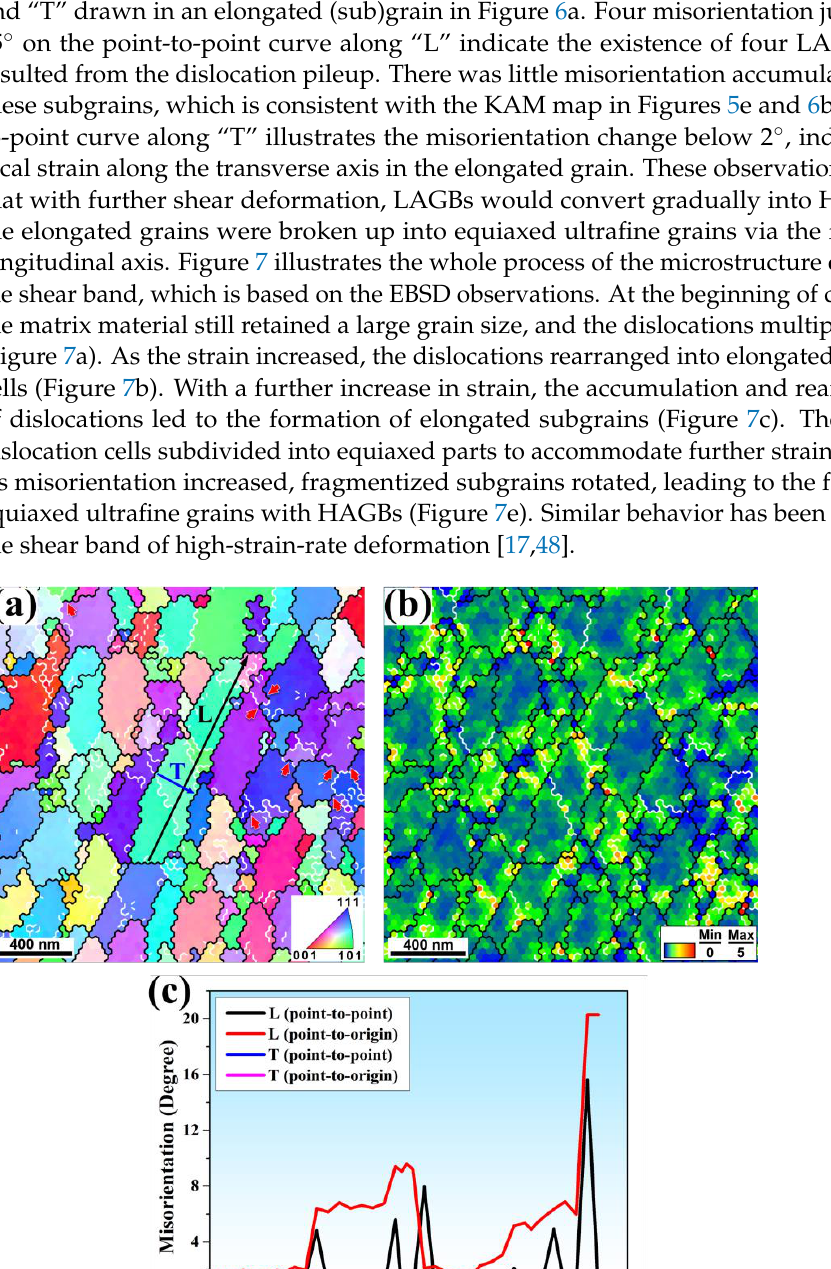
Figure 7. The schematic illustration showing the microstructure evolution in the shear band: ( a ) original equiaxed grain with uniform dislocation distribution; ( b ) formation of dislocation cells; ( c )